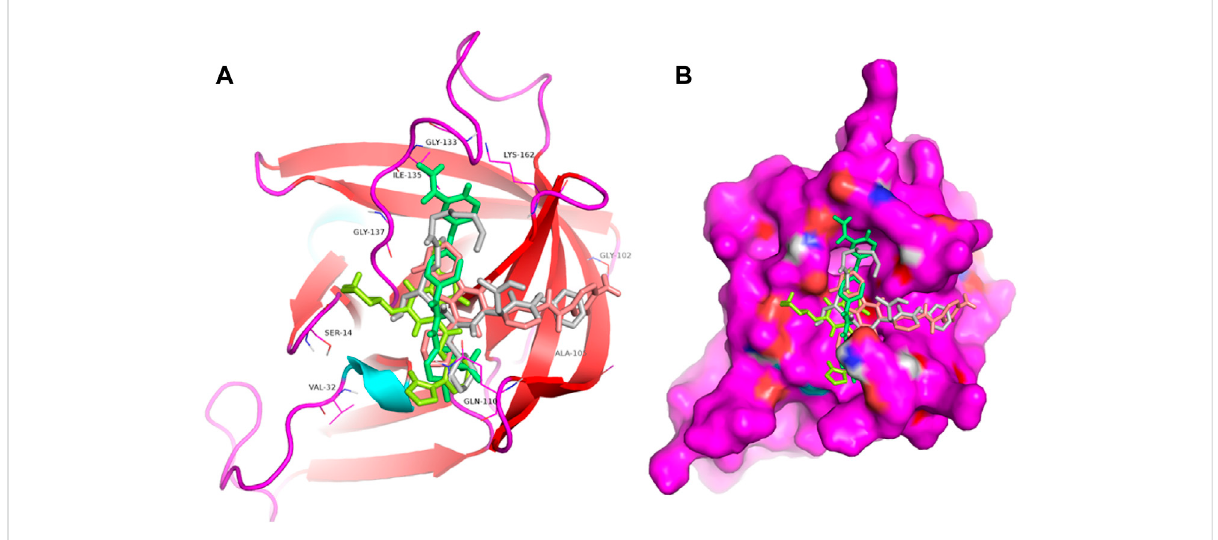
FIGURE 1 Structural alignment of screened lead compounds (sorafenib, LDC4297, YM201636) and dipeptidyl inhibitor seven in the 3CLP binding pocket (A,B)